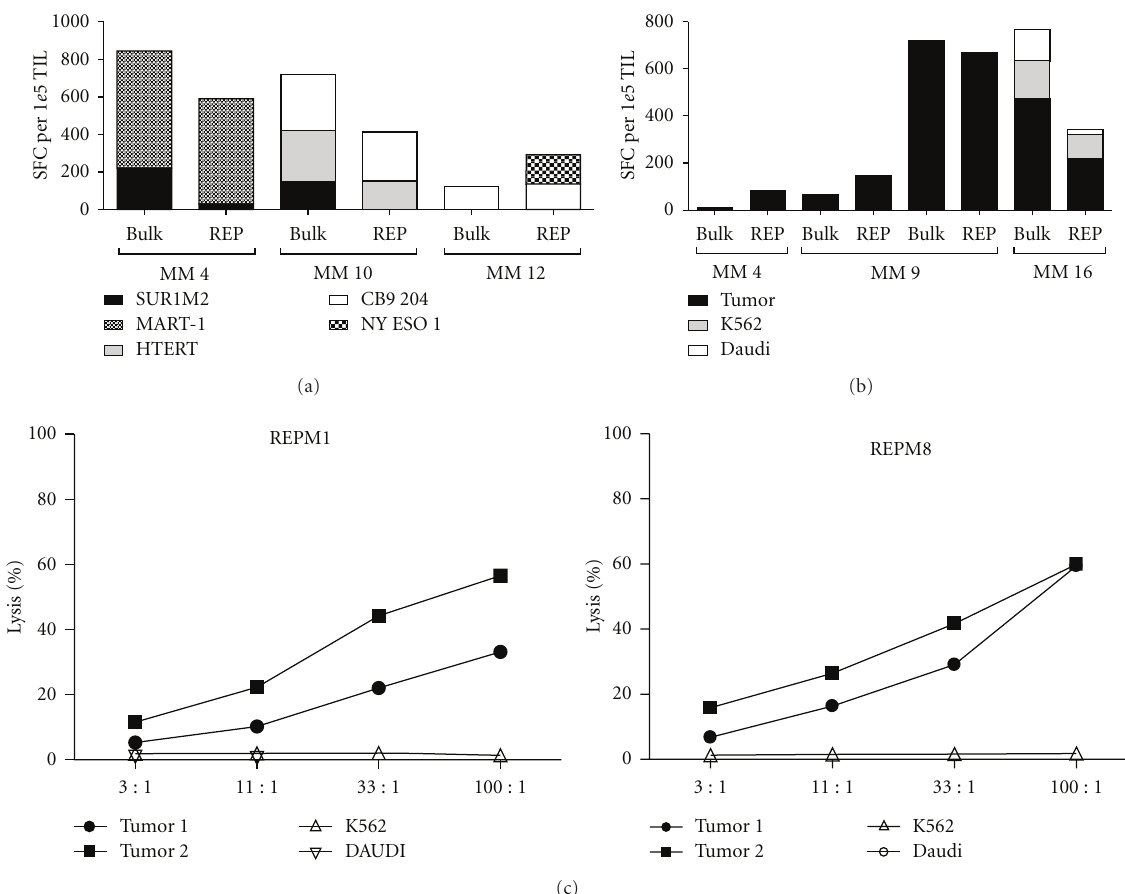
Figure 3: Functional capacity . Determination of TAA peptide-specific populations in TIL pre- and post-REP. Results from Elispot detection of INF γ in three patients exemplifies the general tendency of specificity retention, decline, and/or increase as a consequence of unspecific stimulation during expansion procedures, (a) Autologous tumor cell lines were available from four patients, and all showed TIL with antitumor activity by measuring INF γ in Elispot. Representative results of TIL from three patients show retained tumor-specific activity. However, in patient MM + 16 we found a component of unspecific NK/LAK cell activity, which seemed to decline after REP, (b). Example of preserved lytic capacity of TIL from MM 11 after REP. Both cultures show specific killing of two established autologous tumor cell lines. Interestingly, Tumor 1 seems more immunogenic than Tumor 2,